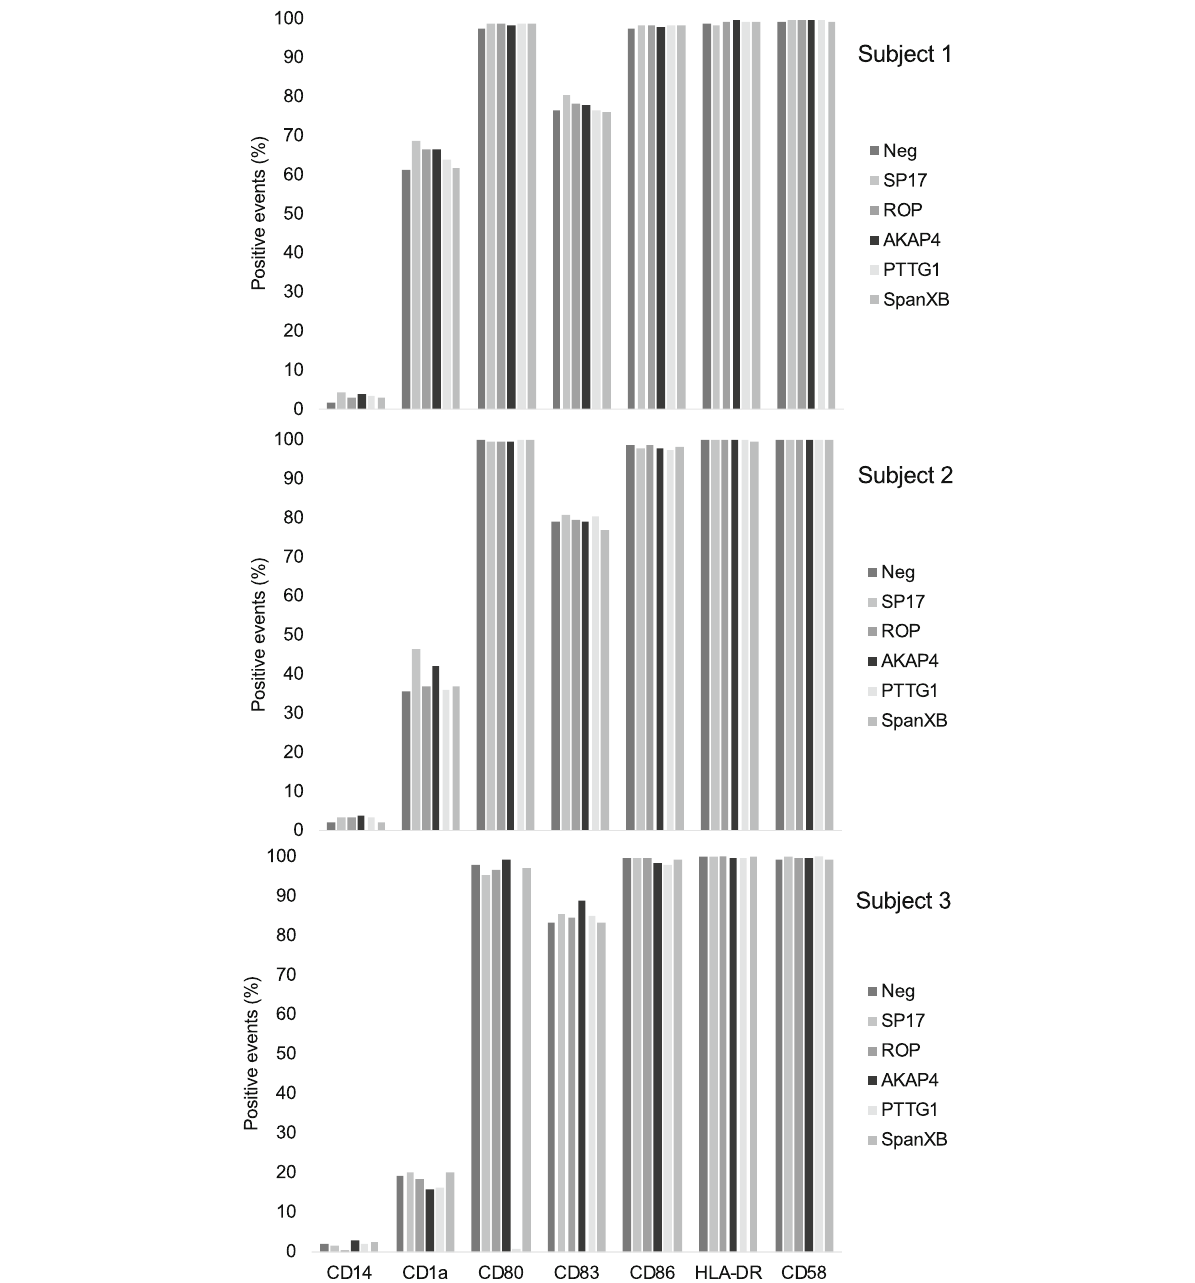
Fig. 3 Immunophenotype of pulsed mDC. Cells were characterized using the indicated differentiation and activation markers by flow-cytometry. No statistically significant difference was noted in the percent of positive events for each CD antigen across tested antigens or subjects (all one- way ANOVA p >